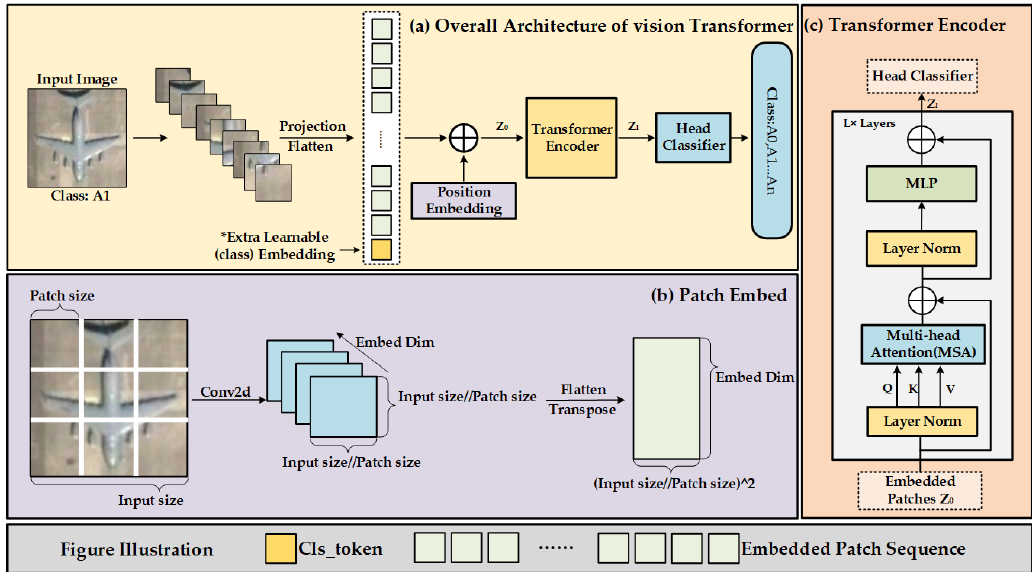
Figure 4. The original Vision Transformer